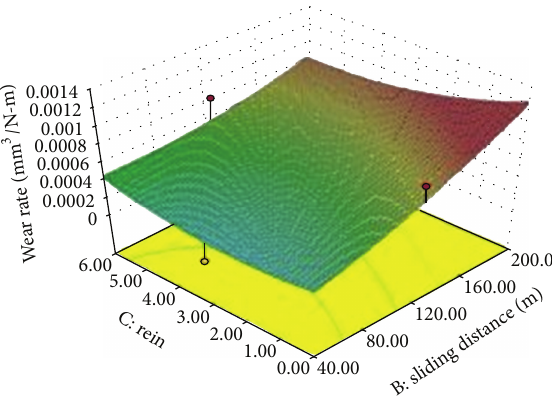
Figure 5: Variation of porosity of Al-Gr composites with varying density.